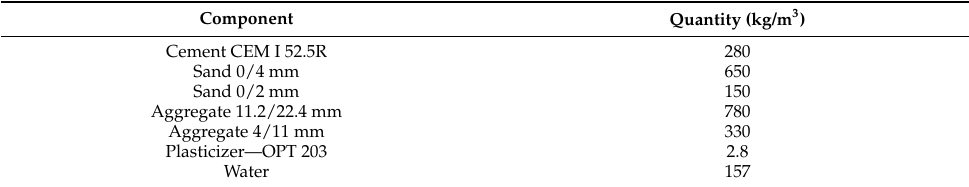
Table 1. Concrete formula.